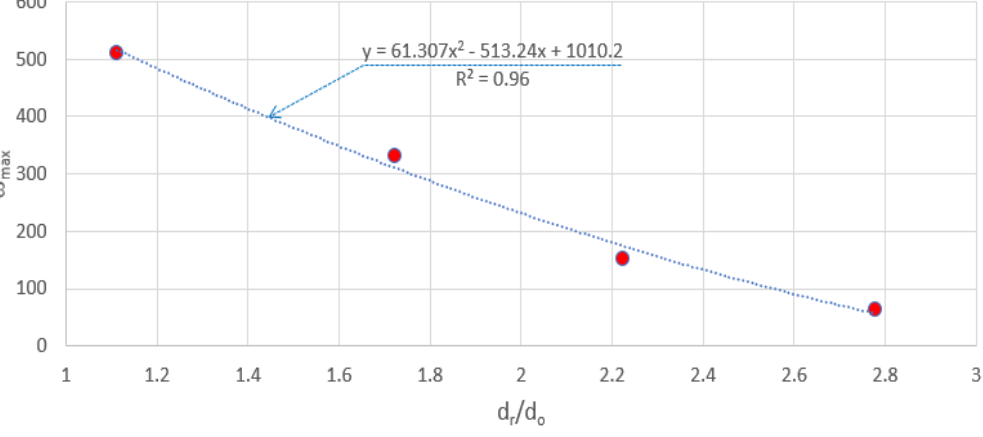
Figure 14. Relation of the maximum rotor’s angular speed with the rotor’s size (4-blade rotors).